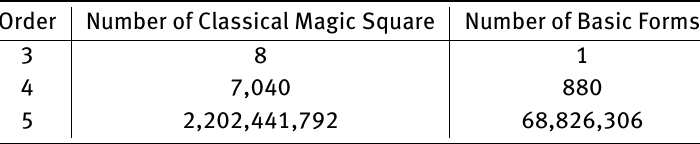
Table 1: The total number of all MS- 3 , MS- 4 and MS- 5 and their basic